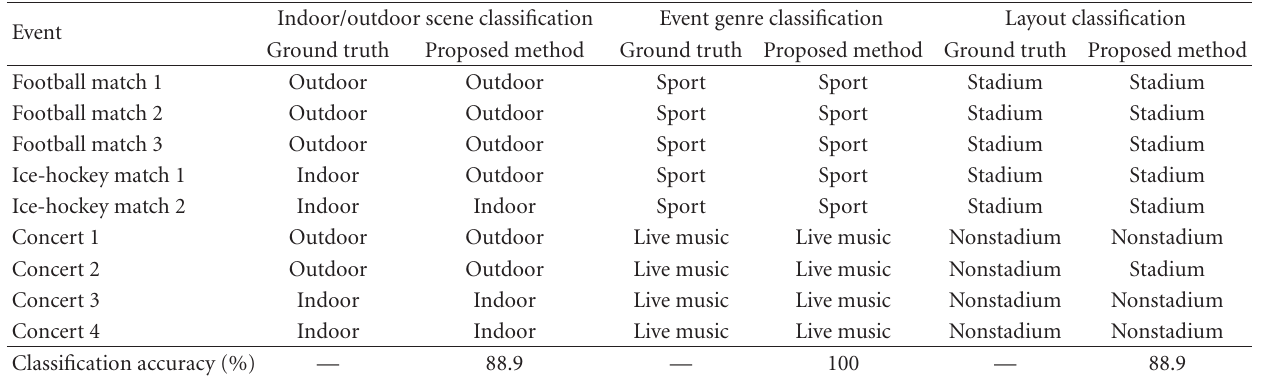
Table 2: Classification of events according to scene, genre, and